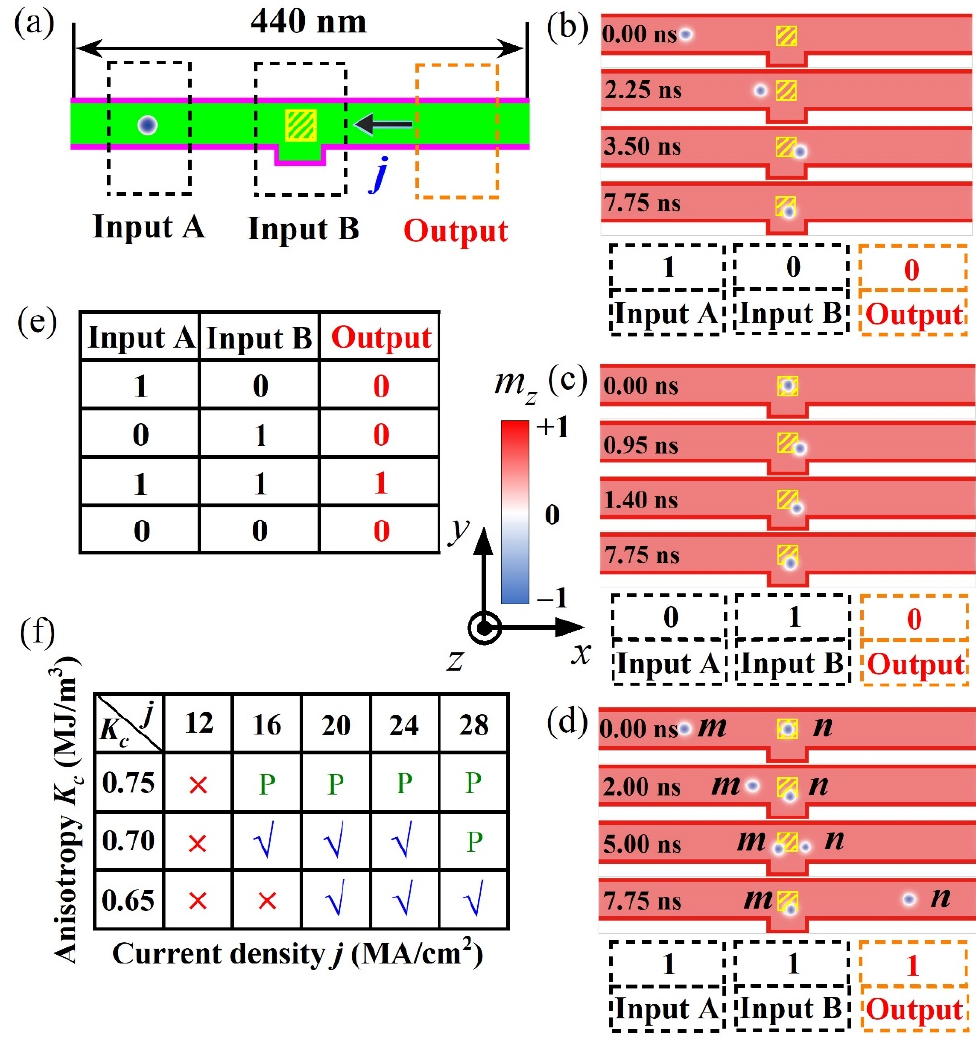
Figure 4. Layout for logic device and logic AND operation. ( a ) Sketch of logic device consisting of three main regions, i.e., ‘Input A’, ‘Input B’ and ‘Output’. ( b , c ) The movement of an isolated skyrmion in panel ( b ) ‘Input A’ or ( c ) ‘Input B’ driven by in-plane spin current, achieving the logic AND operation of panel ( b ) ‘1 + 0 = 0’ or (c) ‘0 + 1 = 0’. ( d ) The movements of two skyrmions located in ‘input A’ and ‘input B’ driven by in-plane spin current, realizing the logic AND operation of ‘1 + 1 = 1’. All the AND operations in panels ( b – d ) are carried out under constant K c = 0.7 MJ/m 3 and spin current density j = 16 MA/cm 2 . The size of the square-shaped capping island in the ‘Input B’ region is 25 nm × 25 nm. ( e ) The table for the logic AND operations. ( f ) The diagram shows the parameter window for realizing the AND operations. ‘ √ ’ and ‘×’ represent the capability and inability of realizing the AND operations. ‘P’ denotes the ‘pass’ state for the isolated skyrmion when it runs through the potential well, which also fails to meet the requirement of AND operations.